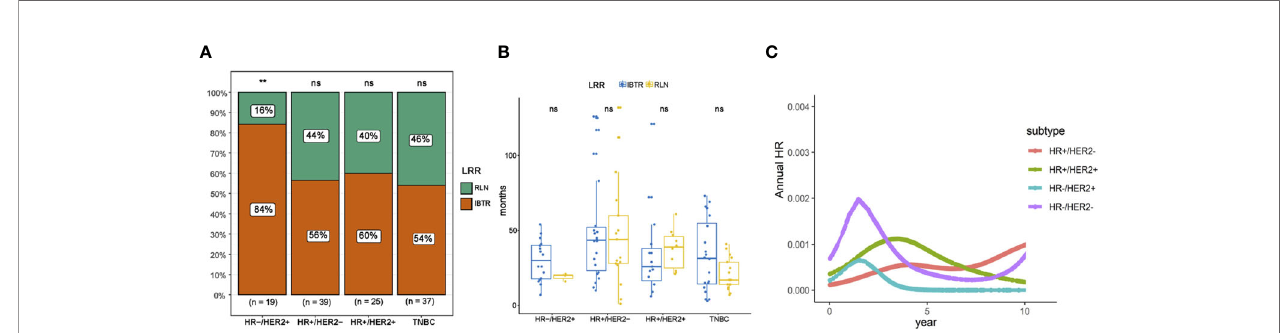
FIGURE 4 | Patterns of recurrence based on molecular subtype. (A) Distribution of recurrence type on the basis of molecular subtype. (B) Comparison of recurrence-free interval between different recurrence types on the basis of molecular subtype. (C) Annual recurrence rates of loco-regional recurrence speci fi ed by molecular subtype. IBTR, ipsilateral breast tumor recurrence; RLN, regional lymph node; NS, no signi fi cance. The “ ** ” symbol means the difference is statistically signi fi cant. The expanded form of "ns" means the difference is not statistically signi